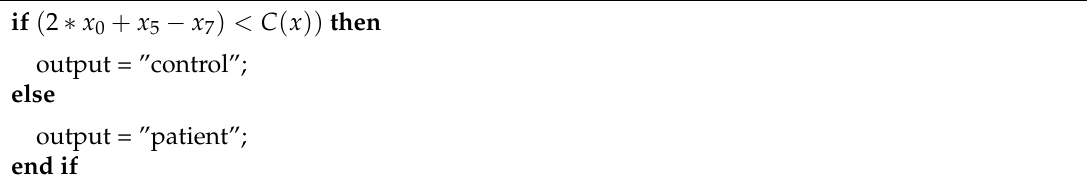
Algorithm 1 The general model inferred by using all the best models at the end of each run. C ( x ) can contain both local and global